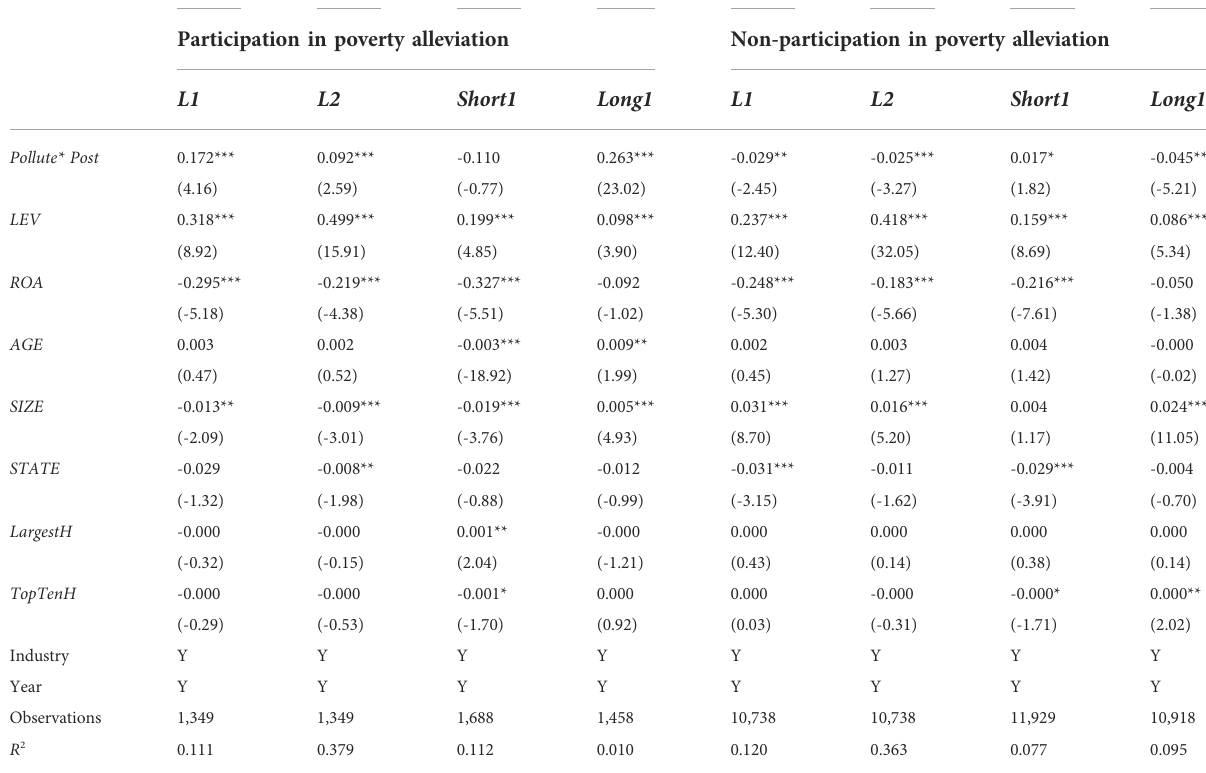
TABLE 8 Bootstrap of corporate participation in poverty alleviation on corporate debt fi